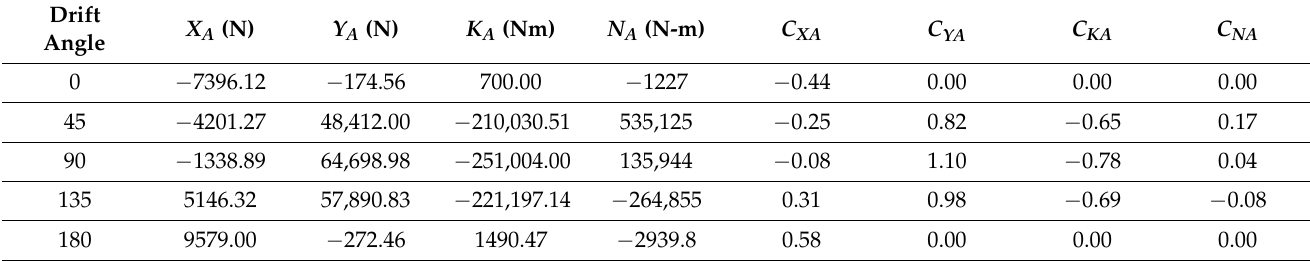
Table 5. The computed aerodynamic forces/moments in full-scale and their